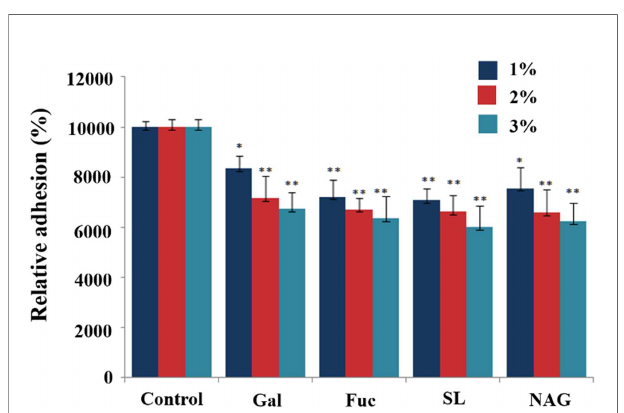
FIGURE 2 | Effects of monosaccharide and its derivatives on the adhesion of C. butyricum to HT-29 cells. The live bacteria were fl uorescently stained with SYTO9 and then incubated for 1h with HT-29 cells. The fl uorescence intensity was measured with the microplate reader at 528nm. Results are expressed as means and standard deviation of three independent experiments with ** P < 0.01 and * P <